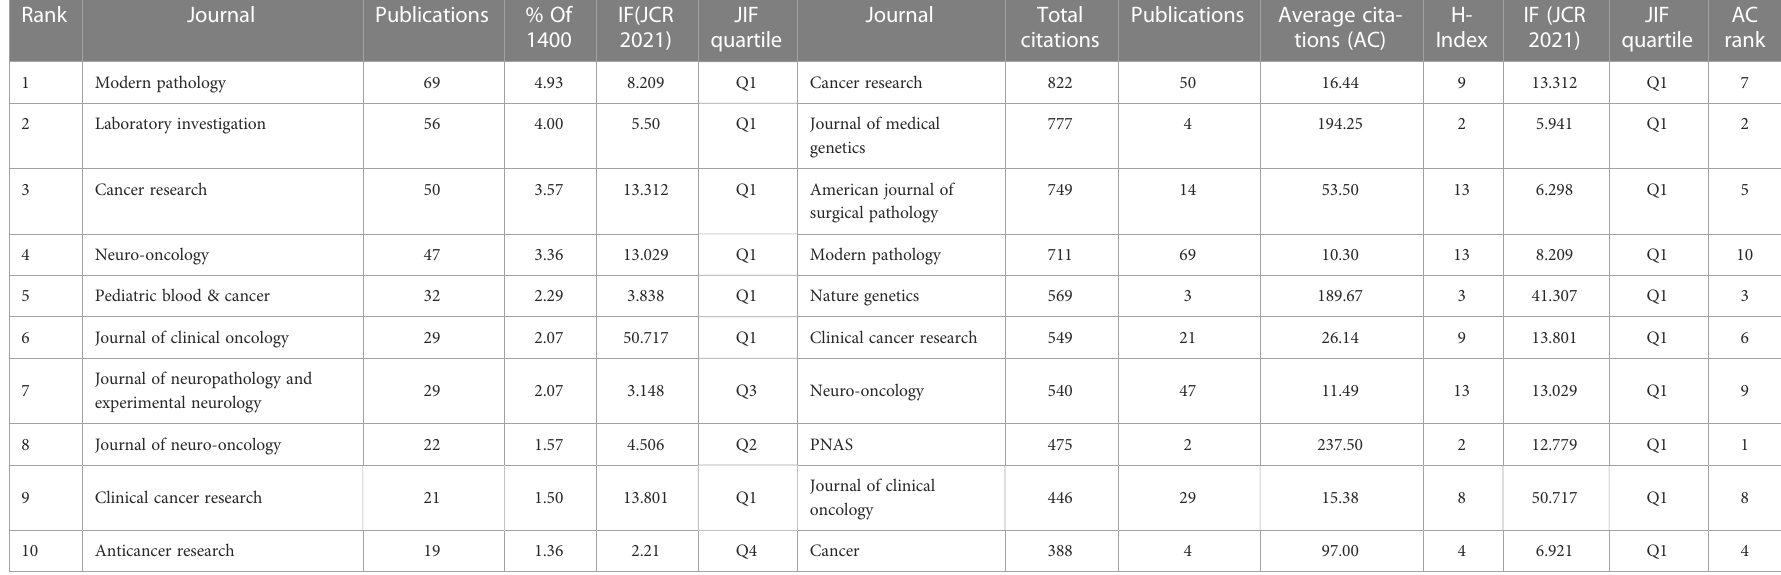
TABLE 6 The top 10 journals based on publications and